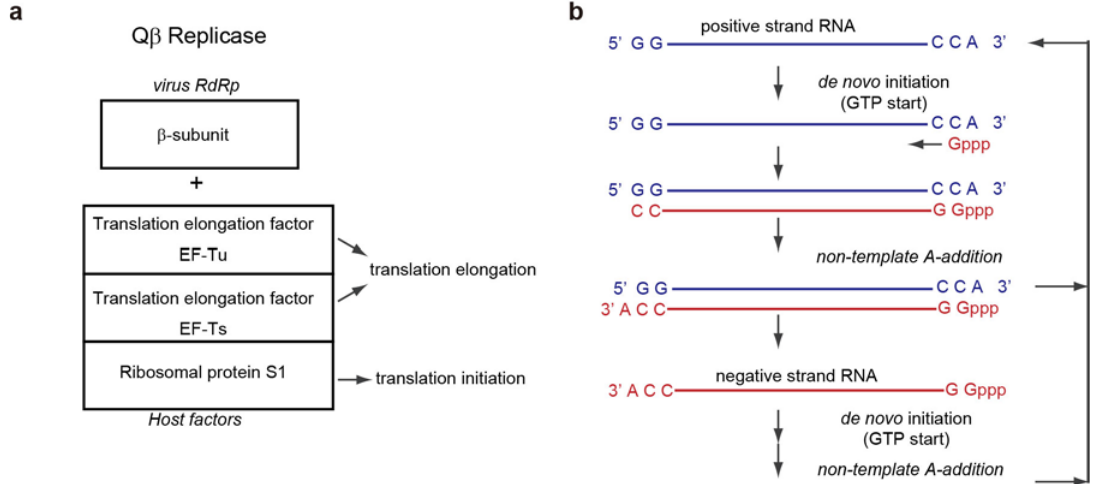
Figure 1. Composition of Qβ replicase and replication cycle of Qβ RNA. ( a ) Composition of Qβ replicase. Qβ replicase consists of the virus-encoded RNA-dependent RNA polymerase (β-subunit), and three host translation factors: elongation factor (EF)-Tu, EF-Ts, and ribosomal protein S1; ( b ) Replication cycle of Qβ RNA. Qβ virus has a single positive strand RNA. The positive and negative strand Qβ RNAs both have 5'-GG and CCA-3' sequences. A-3' does not serve as a template nucleoside, and is added at the terminal stage of RNA synthesis without a nucleic acid